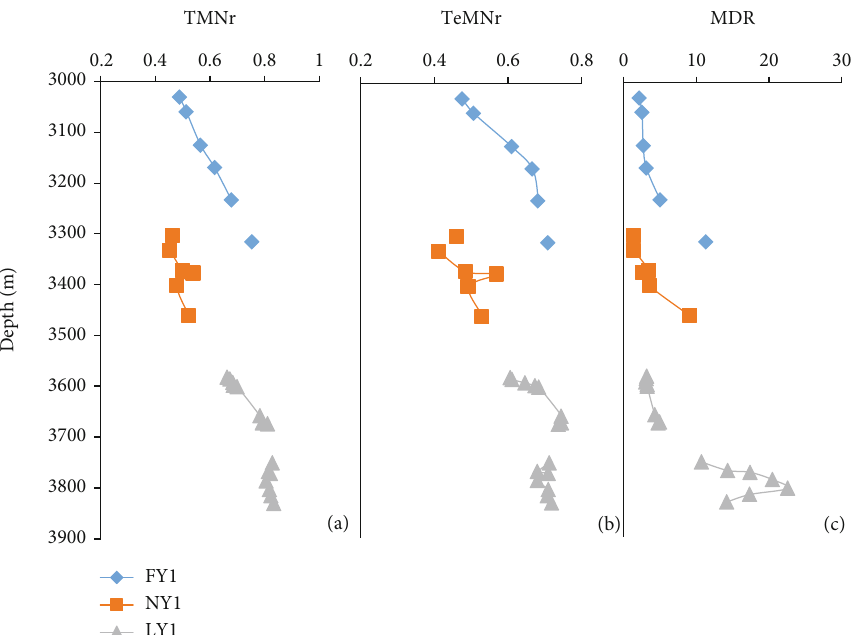
Figure 9: Maturity pro fi le derived from alkylnaphthalenes and alkyldibenzothiophenes in the 3 studied wells. (a) Trimethylnaphthalene ratio (TMNr). (b) Tetramethylnaphthalene ratio (TeMNr). (c) Methyldibenzothiophene ratio